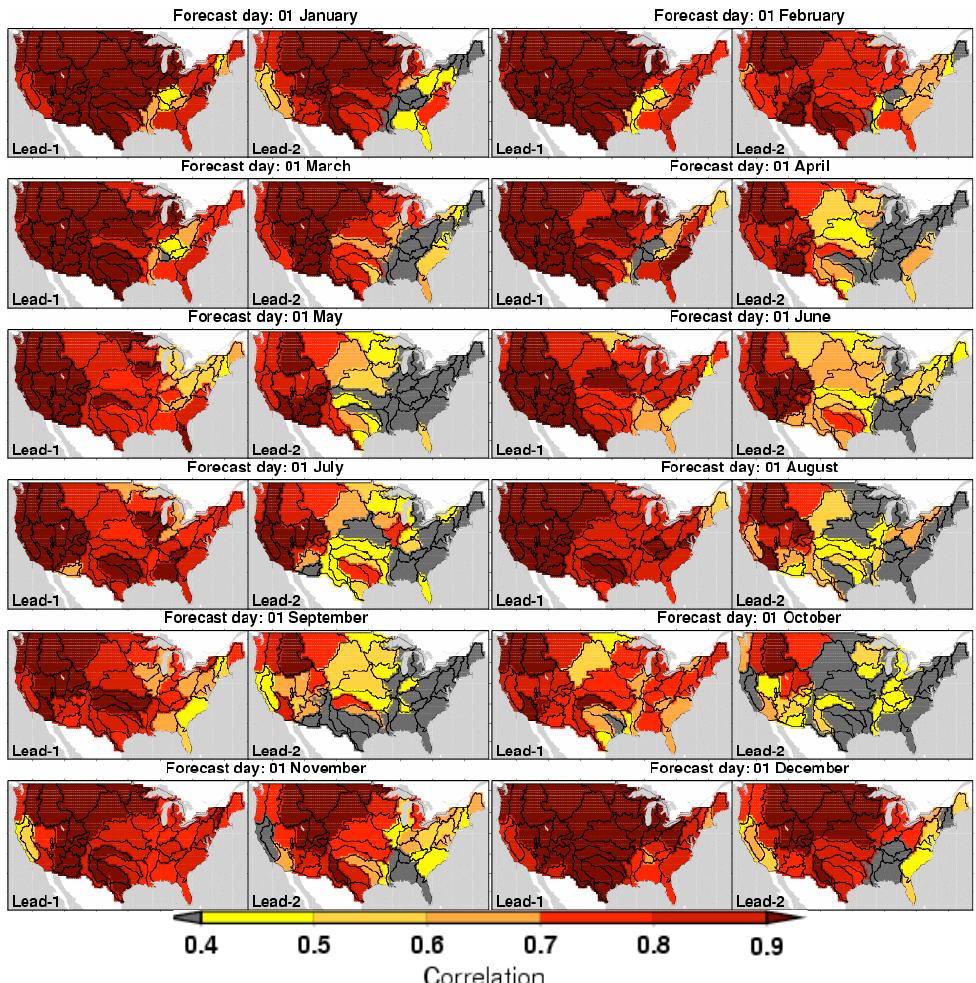
Fig. 7. Baseline skill (i.e. skill of ESP experiment) for SM forecasts at leads 1–2 months (dark grey color shows the sub-regions where the baseline skill is not significant at the 95% significance Figure 7: Baseline skill (i.e., skill of ESP experiment) for SM forecasts at leads 1-2 4 months. (Dark grey color shows the sub-regions where the baseline skill is not 5 significant at 95% significance level.) 6